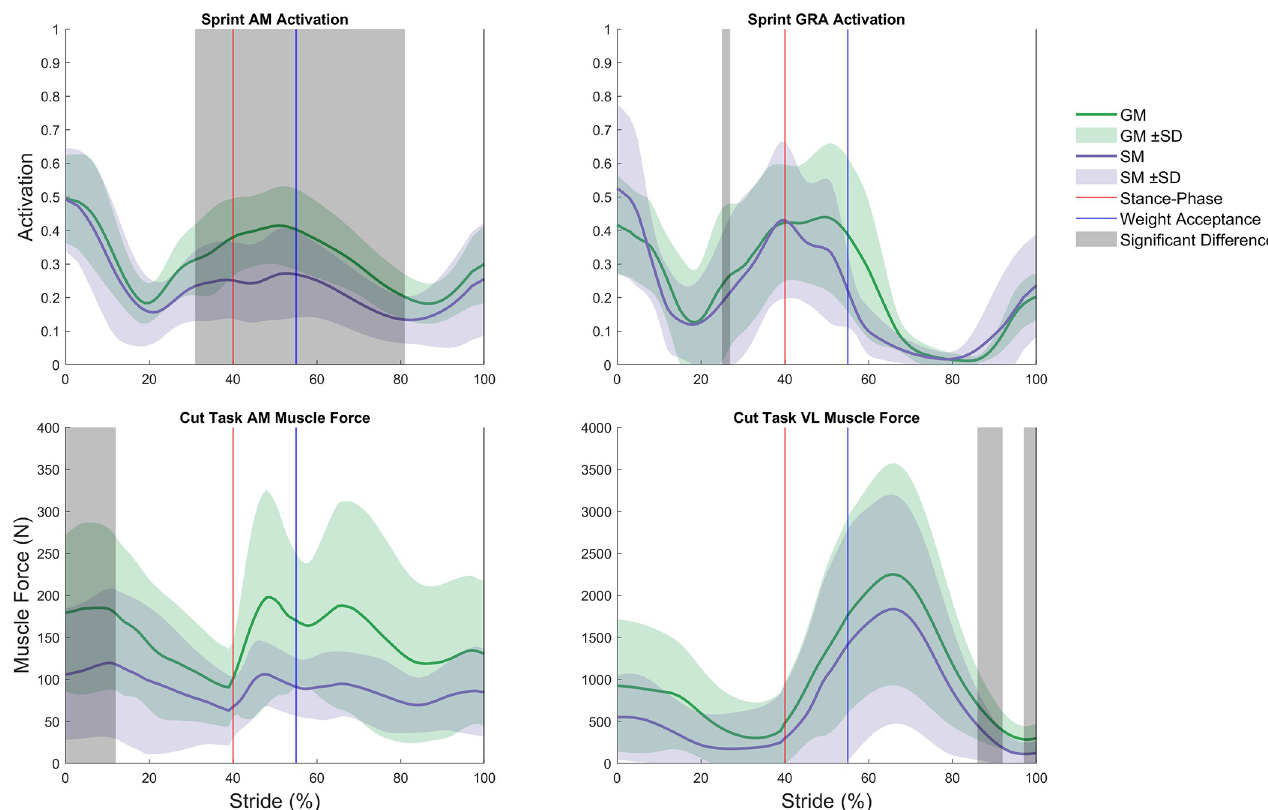
Fig 3. Significant activation and muscle force differences between generic and subject-specific models. AM, adductor magnus; VL, vastus lateralis; Generic model (GM), subject-specific model (SM), and respective variation between participants as standard deviation. Foot ground contact of the stance limb depicted as the red line. End of weight acceptance phase depicted as the blue line. Areas of significant difference, as determined by statistical parametric mapping (grey).